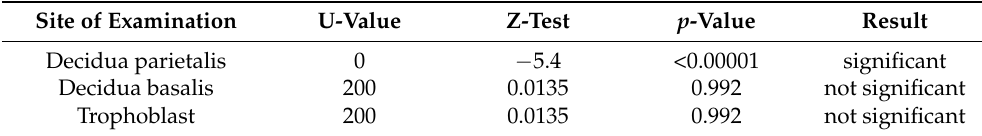
Figure 9. CD3, CD4, CD8, and CD20 antigen expression percentage in the decidua parietalis. The CG samples displayed negative CD3 and CD4 antigen expression, while the EG samples presented moderate CD3 and CD4 antigen expression. The CD8 antigen expression was negative in the CG specimens. Twenty-five percent of the EG samples presented weak CD8 antigen expression, while half of the group presented moderate and 25% strong expression. Finally, all the control samples were negative for CD20, while 25% of the EG samples were weak and 75% moderate. The result is significant at p- value < 0.05. Table 5. CD3 + comparison among the experimental (RPL) and control (electively abortion)